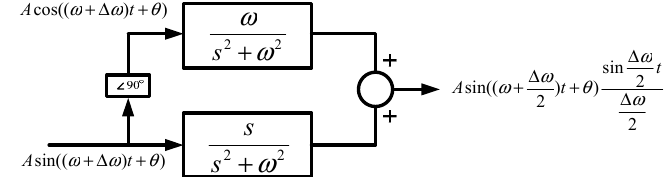
Figure 3. Universal integral equation.